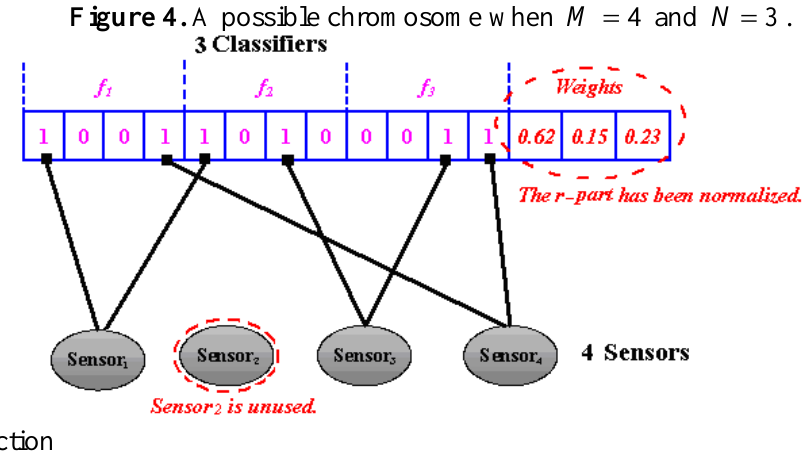
Figure 4. A possible chromosome when 4 M  and 3 N 